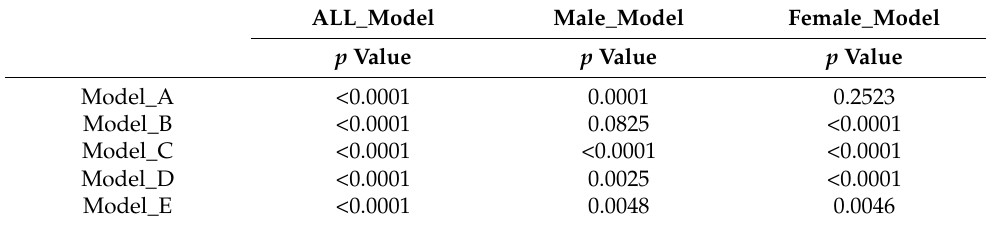
Table 5. Results of the Wilcoxon rank sum test.